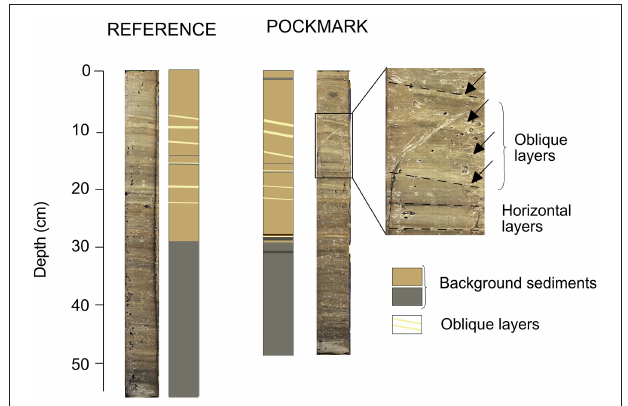
FIGURE 7 | Photographs and lithology of short sediment cores collected inside a unit pockmark and at the reference site (outside the pockmark) at